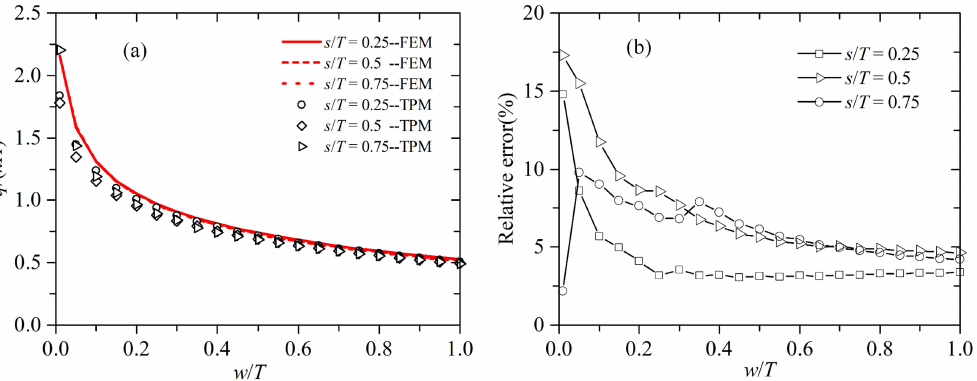
Figure 10. Comparison of flow calculation results between TPM and FEM when k’ / k = 0.9: ( a ) flow calculation results and ( b ) relative